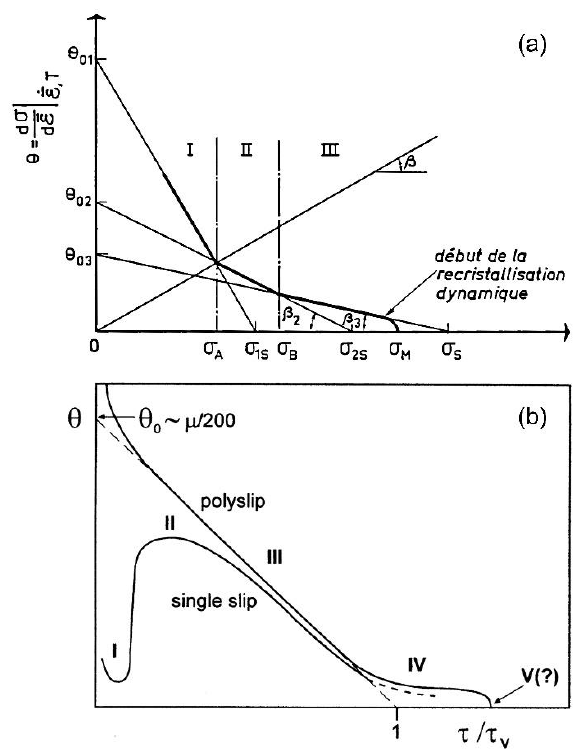
Figure 3. ( a ) Schematic representation of the strain hardening rate–stress curve ( θ – σ ) [107] and ( b ) hardening stages for polycrystals in comparison with those for single crystals deformed in single slip. Reprinted from [92] with permission from Elsevier